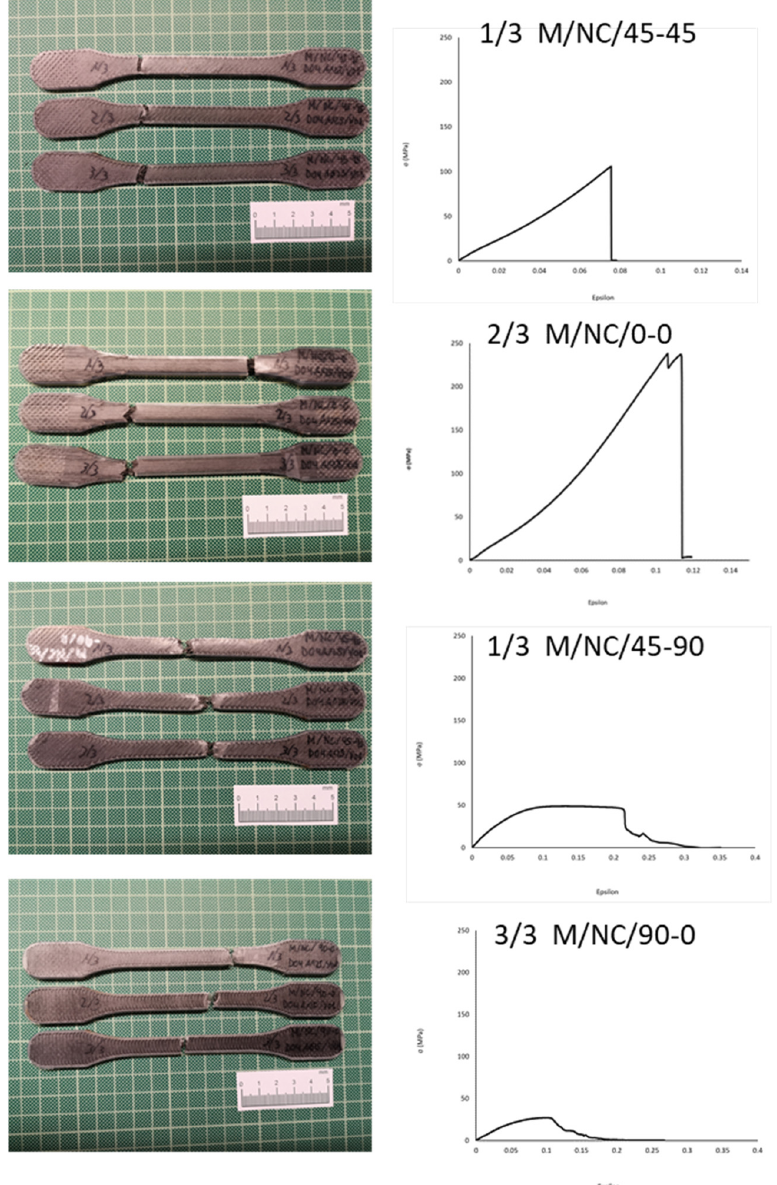
Figure 22. Nylon + CarbonFiber M/NC/45-45, M/NC/0-0, M/NC/45-90, and M/NC/45-90 specimens and Stress-Strain graphs.